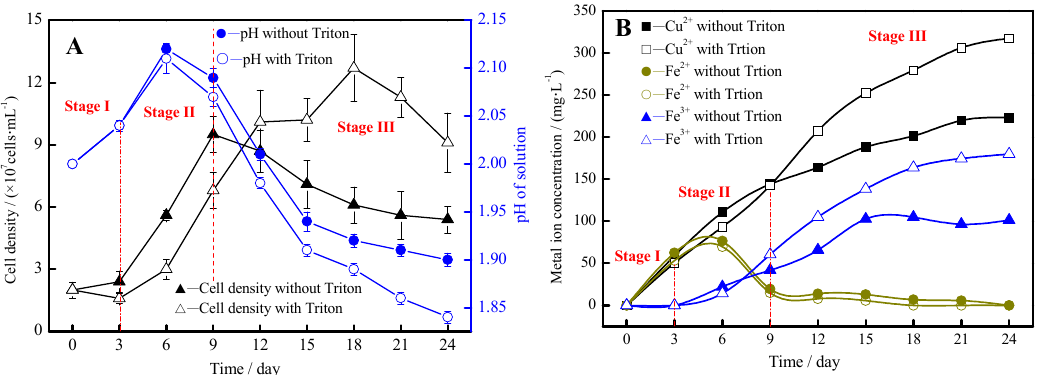
Figure 5. Influences of Triton X-100 on the bioleaching behavior of chalcopyrite. ( A ) Variation of pH and cell density; ( B ) Variation of the concentrations of Fe 2+ , Fe 3+ and Cu 2+ . (Chalcopyrite 1% ( w / v ), Triton X-100 30 mg · L − 1 , initial cell density 2 × 10 7 cells · mL − 1 , initial Fe 2+ 0 g · L − 1 , initial pH 2.0, rotational speed 160 rpm, and temperature 30 °C).